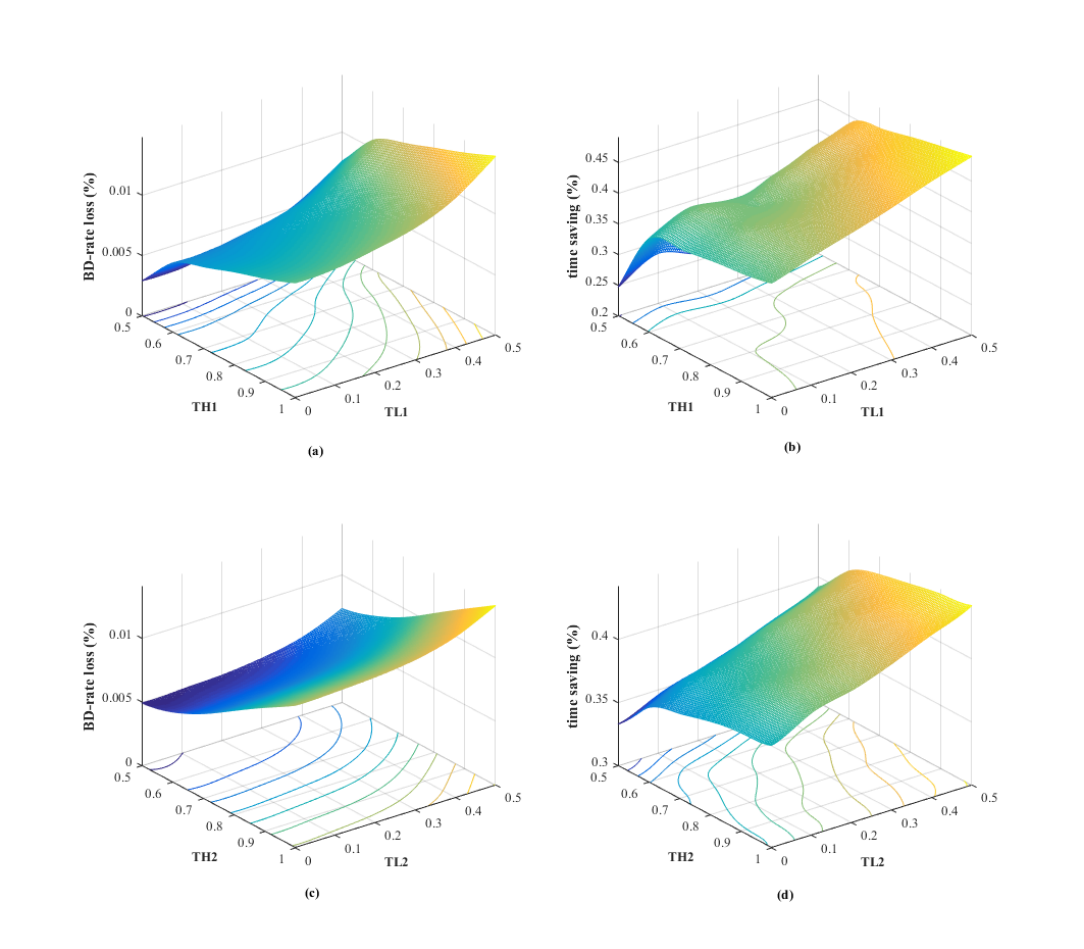
Figure 11. Surface of Bit-Distortion (BD)-rate loss and time saving in the training set with respect to TL 1, TH 1 and TL 2, TH 2. ( a ) the surface of BD-rate loss with respect to TH 1 and TL 1. ( b ) the surface of time saving with respect to TH 1 and TL 1. ( c ) the surface of BD-rate loss with respect to TH 2 and TL 2. ( d ) the surface of time saving with respect to TH 2 and TL